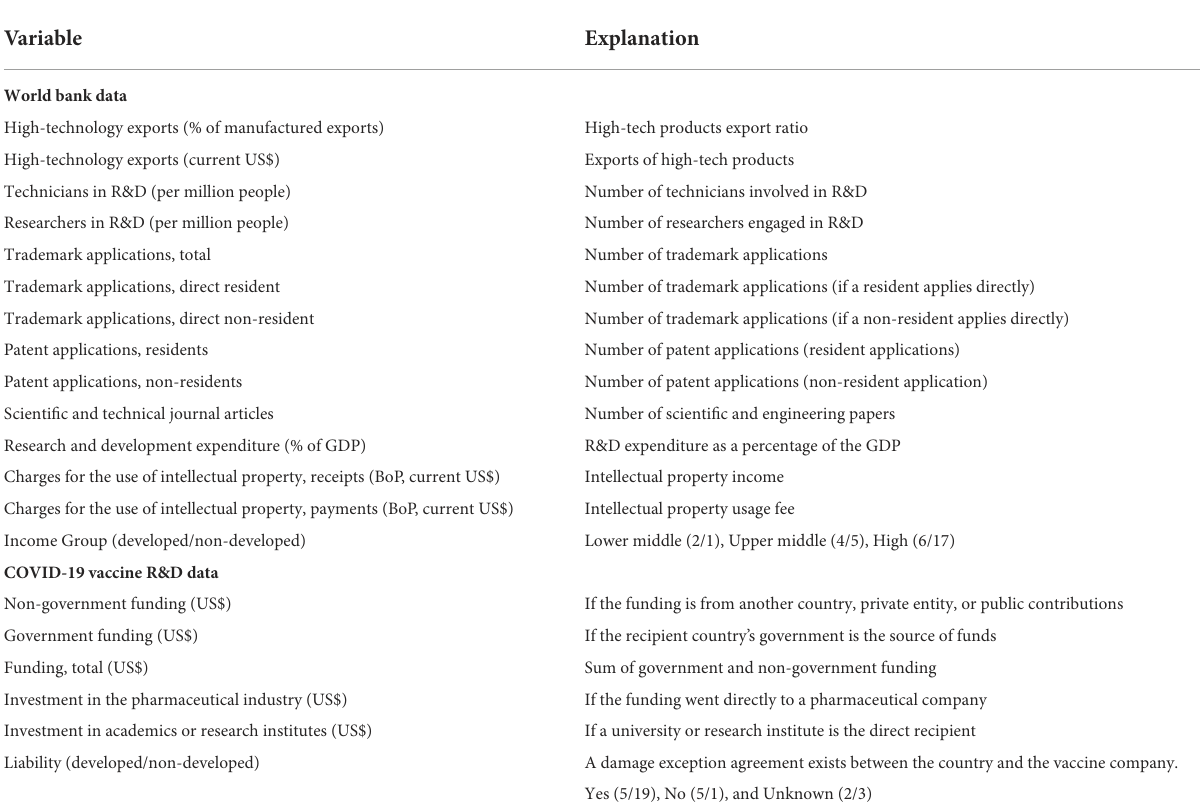
TABLE 2 List of the R&D indicator variables.